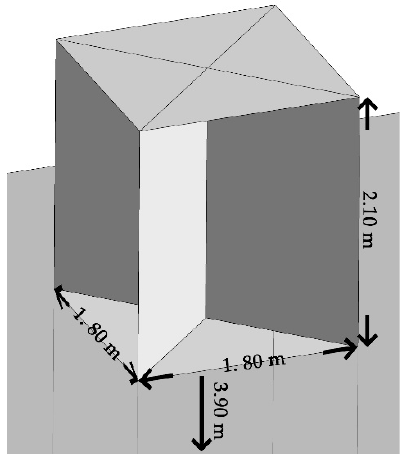
Figure 3. Boundary dimensions of the wind catcher geometry (base case).